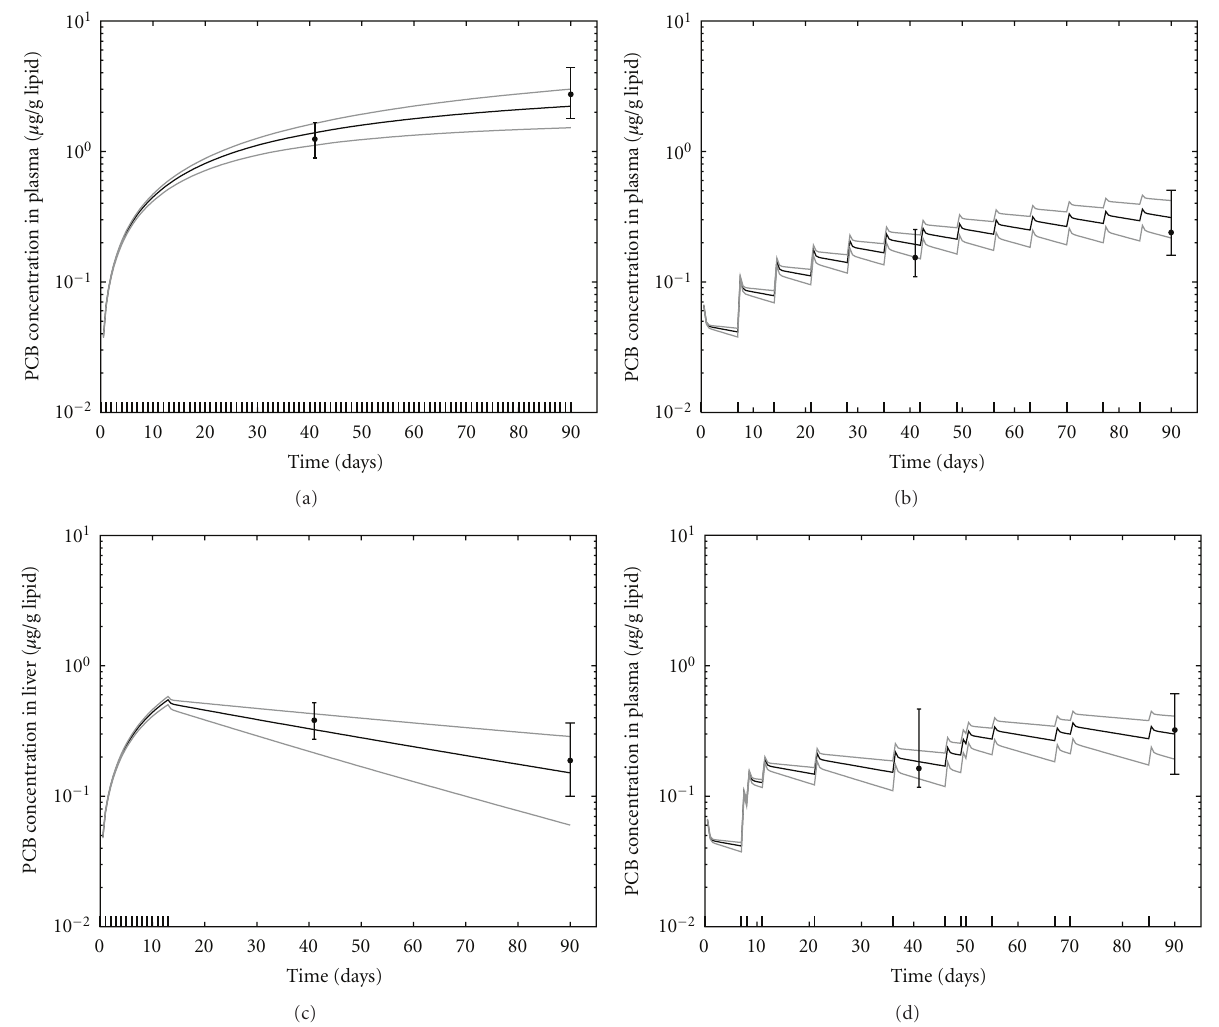
Figure 2: Model predictions and data for all PCB concentrations in tissue lipids at the 5 μ g/kg dose level, and the four dose protocols ((a) Daily, (b) weekly, (c) daily to day 13, (d) nonperiodic). Data points represent the median of all PCBs for all rats at time of sacrifice, and error bars represent the minimum and maximum measured values. Modeled results represent the median and 95% confidence interval of 1000 model runs using parameters randomly sampled from the posterior